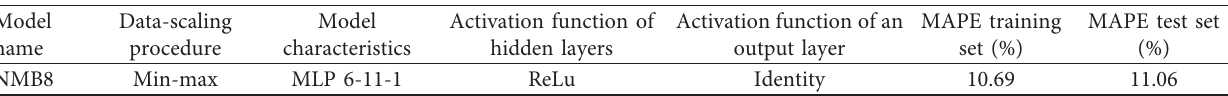
Table 10: Artificial neural network models with random data choice for estimating concrete consumption (LOOCV).